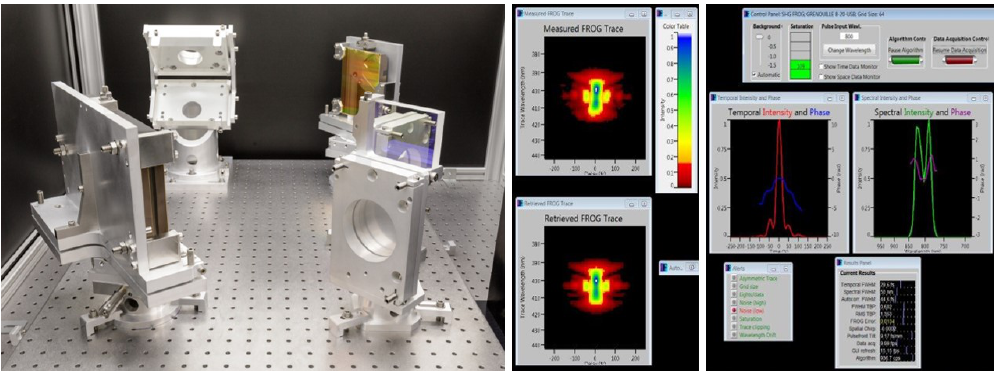
Figure 6: Left: Compressor operating in air with Zerodur gratings aligned in Treacy configuration can compress 40 mJ input pulses. The right panels show the measured and calculated FROG traces (left) and temporal and spatial intensity of the pulses revealing 29 fs pulse duration and 80 nm spectral width at the compressor